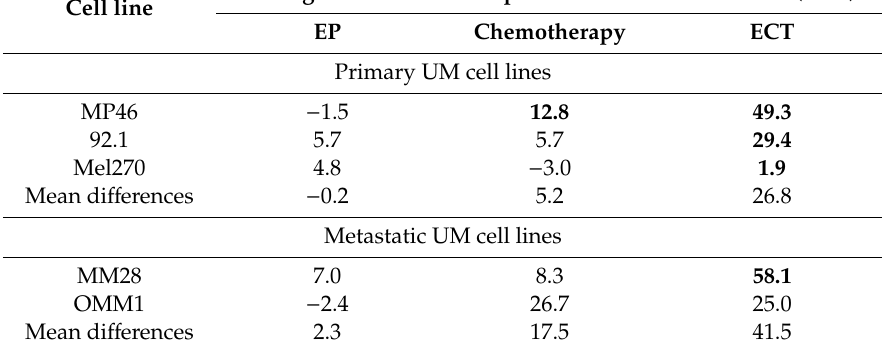
Table 2. Average di ff erences in viability of electroporation alone (EP), chemotherapy alone using bleomycin and electrochemotherapy (ECT) compared to untreated controls at day seven following treatment. Viability was determined using MTT assay. Significant reduced cross-sectional areas ( p value ≤ 0.05) are highlighted in bold. Average Di ff erences Compared to Untreated Controls (in Cell line